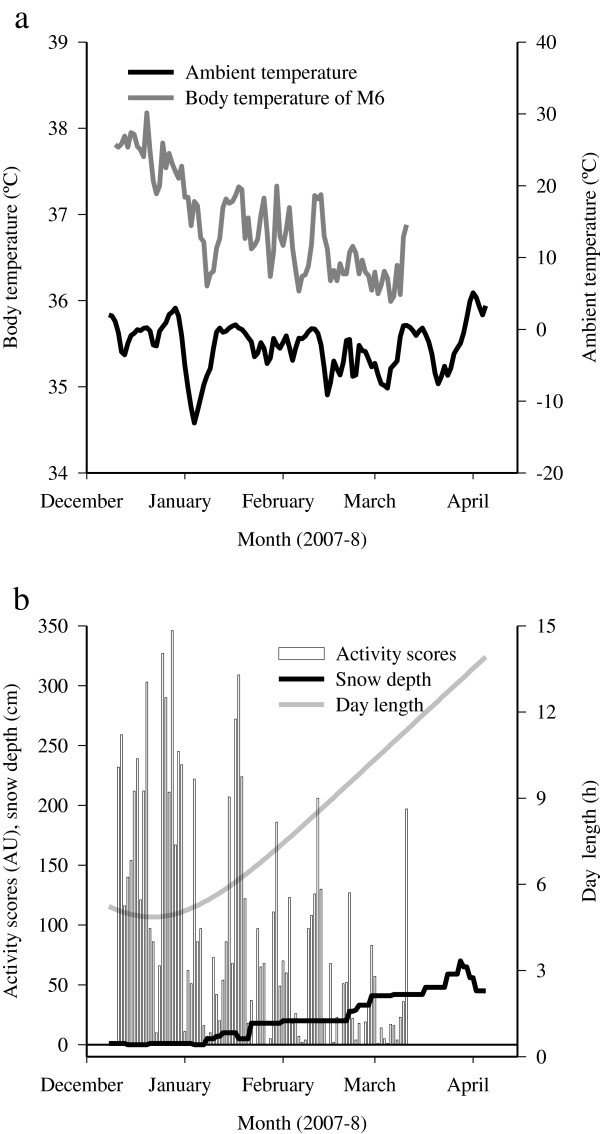
Average 24-h body temperatures and activity score sums and their relation to external factors. (a) The average 24-h body temperatures (°C) and (b) nocturnal activity score sums (arbitrary units; AU) of a juvenile male raccoon dog (M6) were measured in Dec 2007–March 2008 together with the average 24-h ambient temperatures (°C), day length (h), and snow depth (cm).